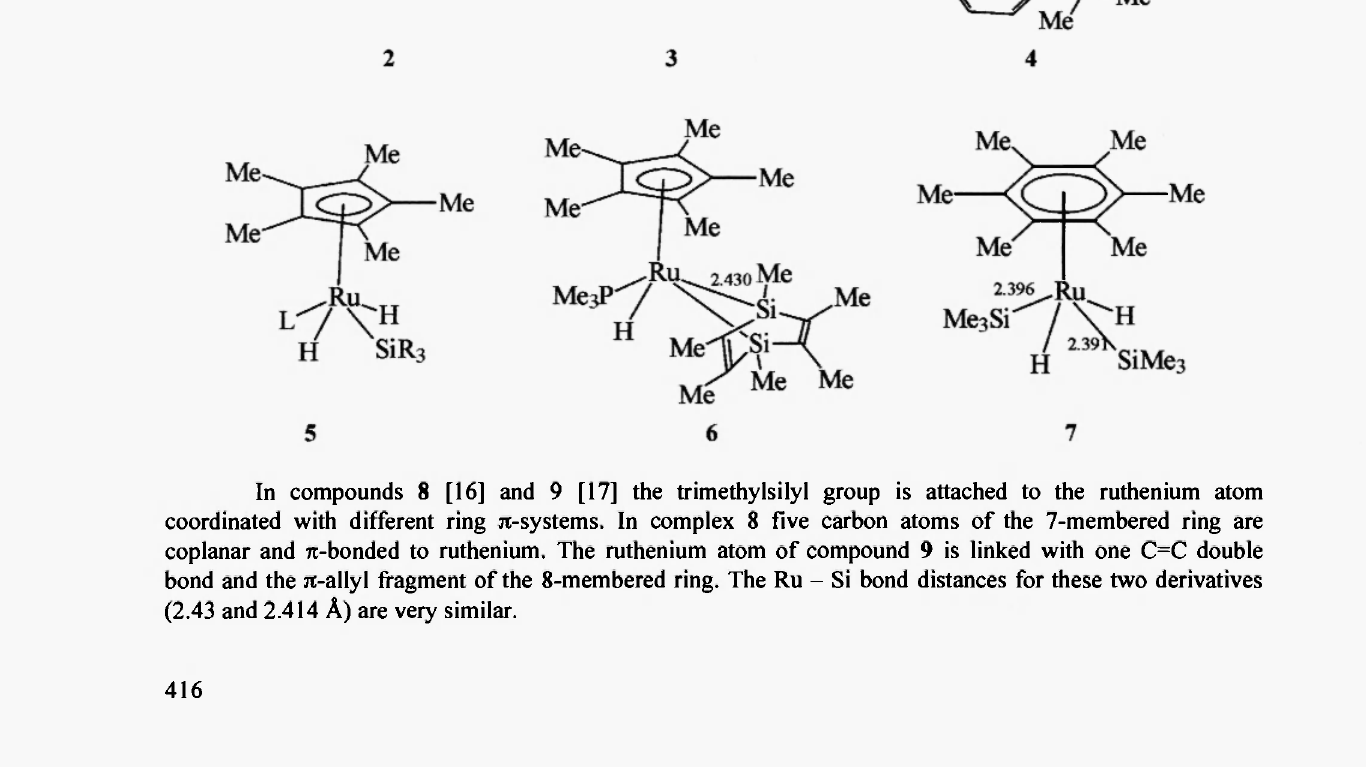
Table 1. Geometrie parameters of complexes